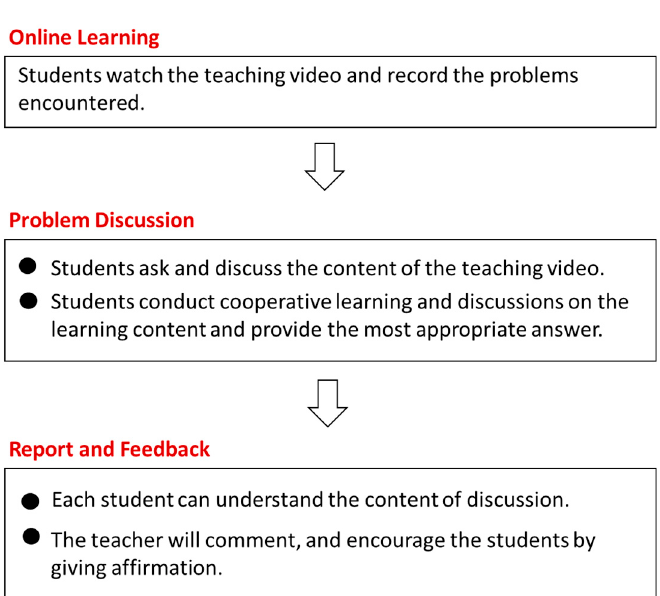
Figure 1. The flowchart of the Flipped Course model.